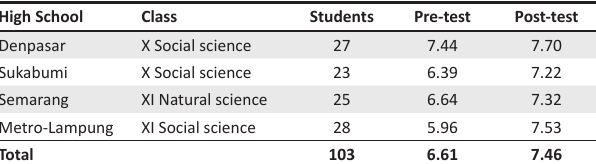
TABLE 2 : Summary of pre- and post-test means.